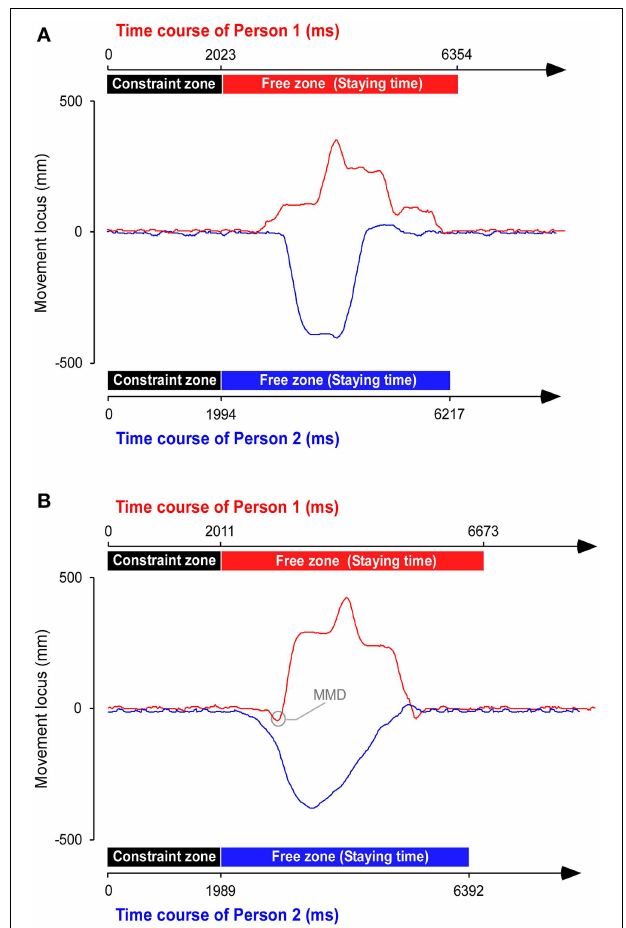
FIGURE 2 | Trajectory of a representative pair. The example shows a trial in which the conditions are synchronization, long distance, and different starting feet of a pair (Person 1 and 2) in (A) control and (B) experimental tasks. The movement locus was simultaneously obtained from both persons. The time axis of Person 2 was inverted, and the start position was adjusted for Person 1. Note the high rate of moving in a mistaken direction (MMD), when a participant moved to one direction initially but ultimately moved to the other direction, in the experimental